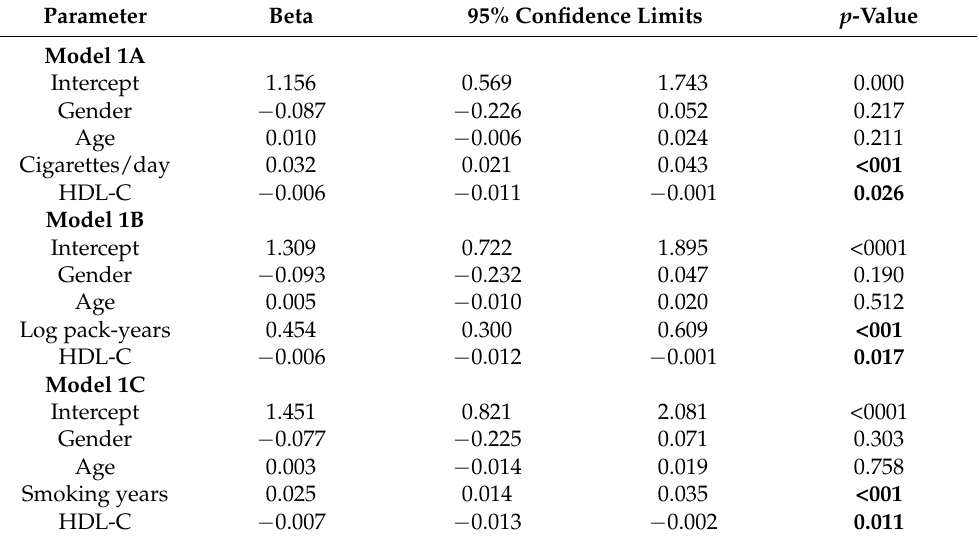
Table 2. General linear models generated considering HDL-SPB as dependent variable adjusting for age, gender, and HDL-C (Model 1 described in Methods section). In addition, model 1A considers cigarettes/day, model 1B pack-years, and model 1C smoking years as independent variable.